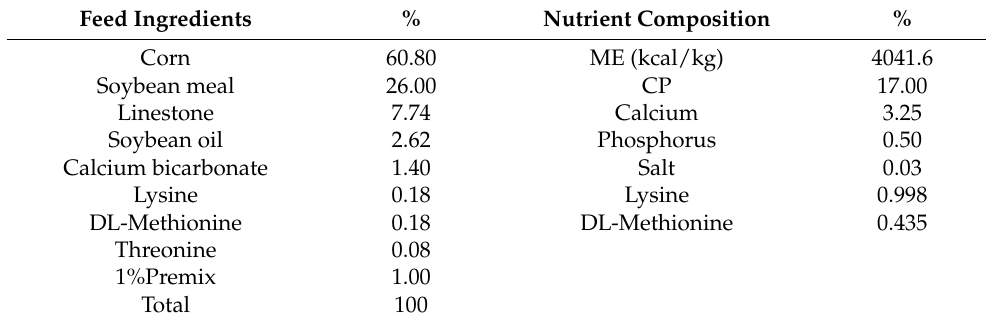
Table 1. Basic diet’s ingredients and nutritional